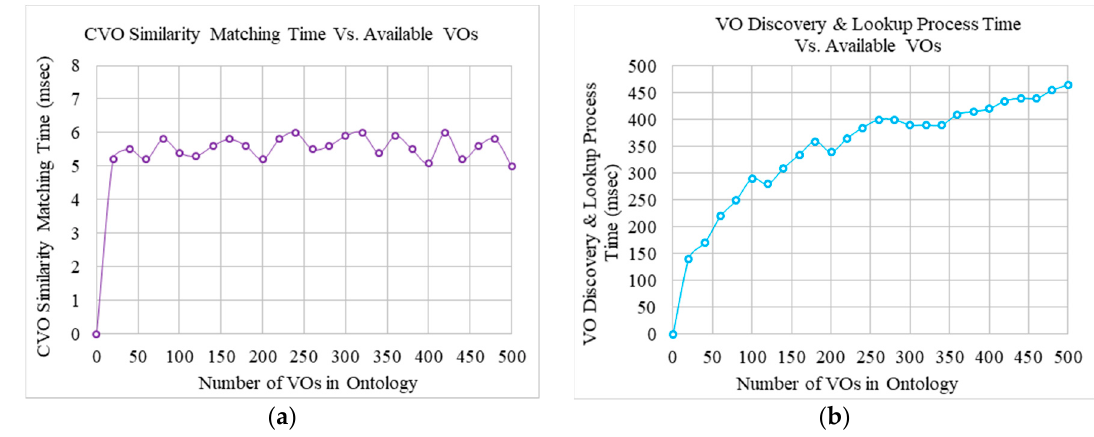
Figure 10. Observation of time required for executing ( a ) CVO similarity matching, and ( b ) VO discovery and search processes in terms of the increased number of VOs.